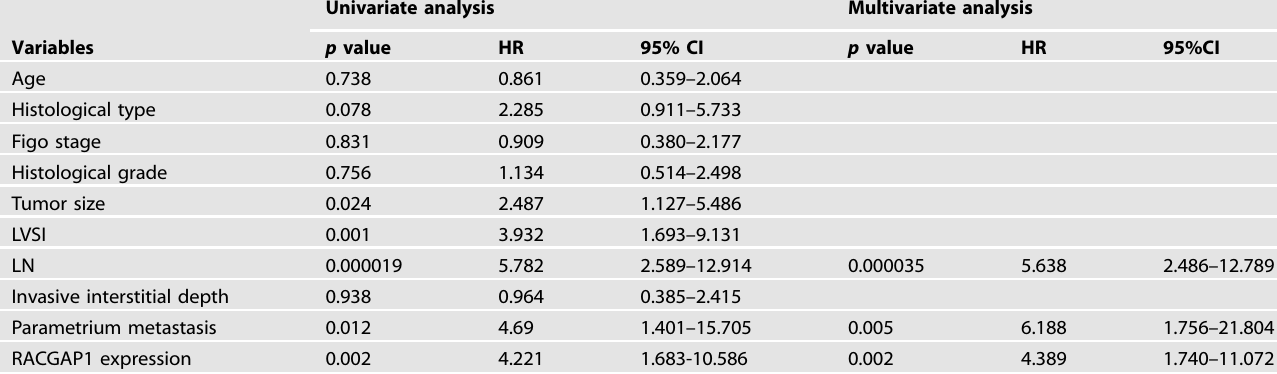
FIGO International Federation of Gynecology and Obstetrics, LVSI lymph-vascular space invasion, RacGAP1 Rac GTPase-activating protein